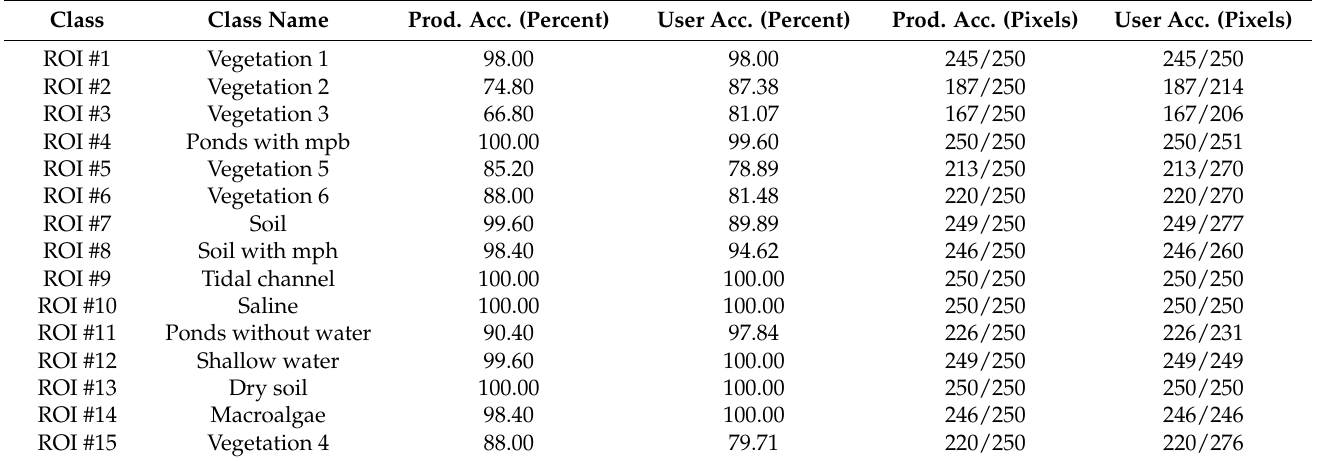
Table A1. Report for the accuracy of the comparison of classification results to Eq250, the equalized samples groups using 250 pixels for each class as reference. The table summarizes the producer accuracy and user accuracy in percentage and pixels for each class.